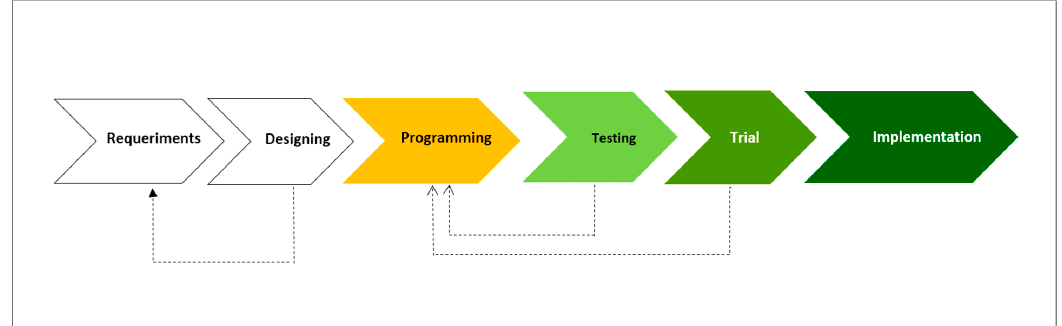
Figure 2. Phases of development, testing and implementation of the information system for the elimination of malaria.